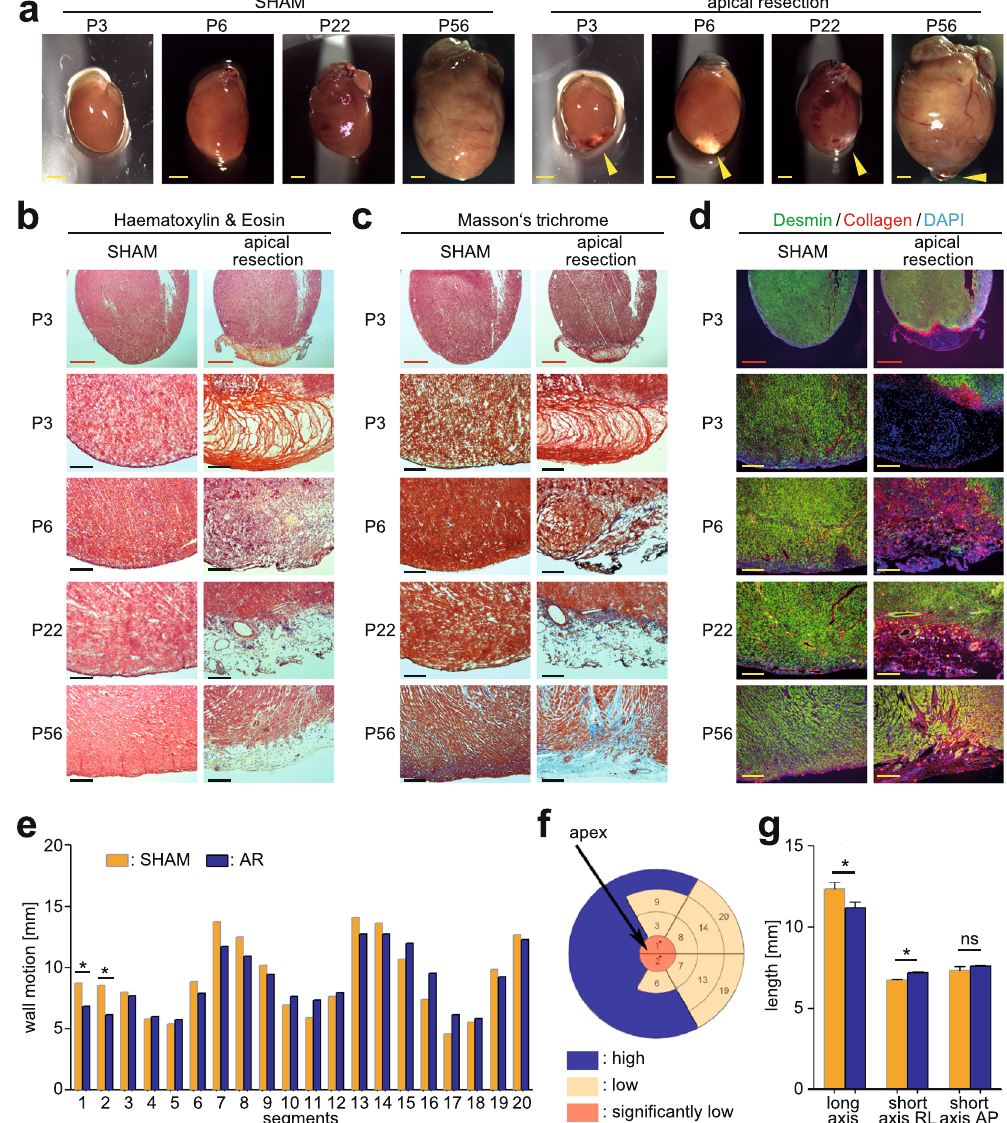
Figure 5. Characterization of AR rat hearts. ( a ) Representative stereomicroscopic images of SHAM- and AR-operated rat hearts at different postnatal time points. Arrow heads indicate myocardial scar. Scale bars: 1 mm. ( b – d ) Representative images of Hematoxylin & Eosin staining ( b ), Masson’s trichrome staining ( c ), and immunofluorescence analysis of non-myocytes (Collagen I/Desmin/DAPI) ( d ) of SHAM- and AR-operated hearts at different postnatal time points. P3–P22 (n = 4–6) and P56 (n = 3) for each group. Red scale bars: 1 mm. Black/yellow scale bars: 200 µ m. ( e ) The mean wall motion of each heart segment was compared between SHAM and AR hearts (n = 3). ( f ) Summary of wall motion depicting heart segments in AR hearts versus those of SHAM demonstrates defects in the apex region. ( g ) Quantitation of heart axes by PET scanning (n = 3). Right-left (RL). Anterior-posterior (AP). Data are ± SEM. * p <